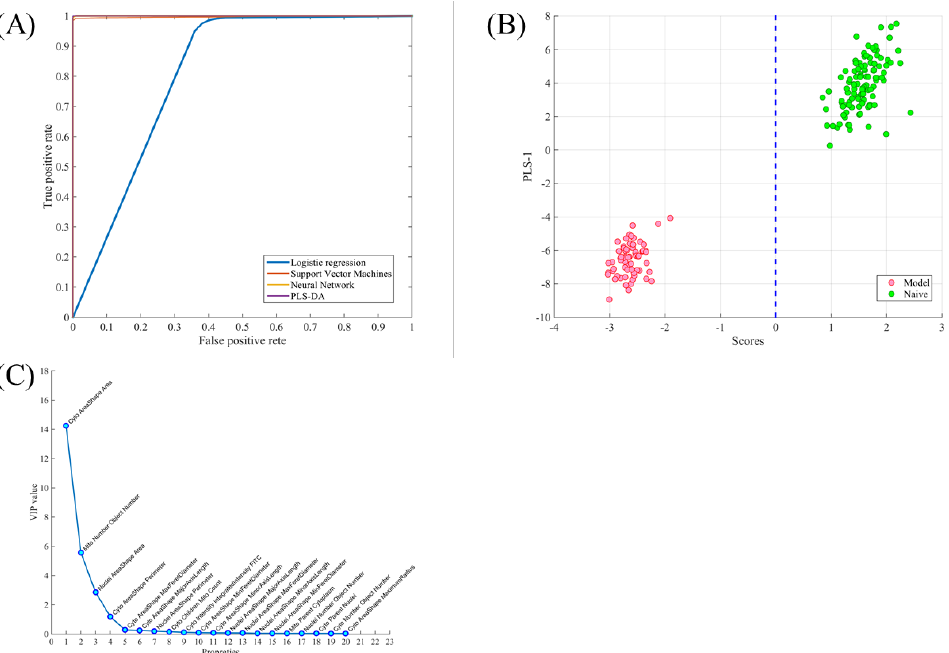
Figure 2. Pattern recognition of model and naïve cells. ( A ) Receiver operator characteristic (ROC) of four models. The area under the curve (AUC) of Partial Least Squares Linear Discriminant Analysis (PLS-LDA) equaled 0.999, which is the highest of all, and the AUC of LogReg equaled 0.719. ( B ) Visualization of the test samples according to the PLS-LDA scores vs. the first latent variable spaces. Data from individual images of model cells (models, red dots, n = 65) and naïve cells (naïve, green dots, n = 109) are separated along the horizontal axis. A score below 0 is classified as a model cell. ( C ) Variable importance in projection (VIP) values with cell properties. This represents the importance of each property in the trained PLS-LDA model.